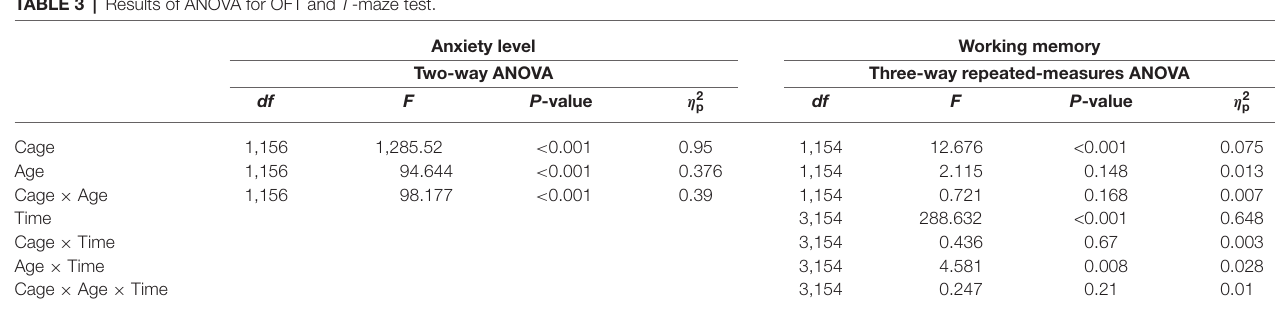
TABLE 3 | Results of ANOVA for OFT and T -maze test.